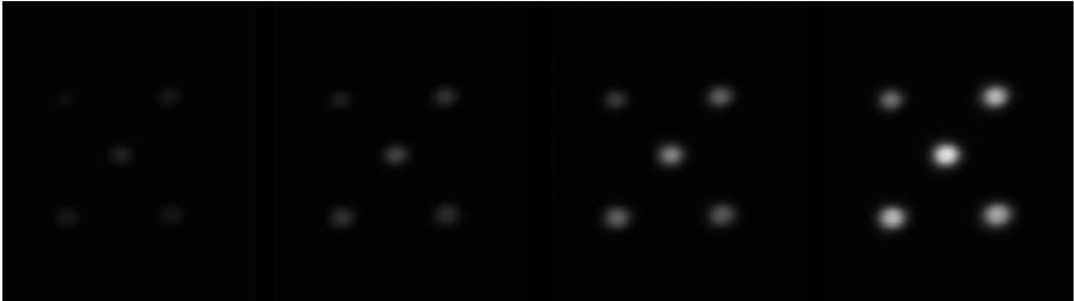
Figure 5. The calibration canvas with different reflectance values ( a ) and the corresponding spectral signatures ( b ).